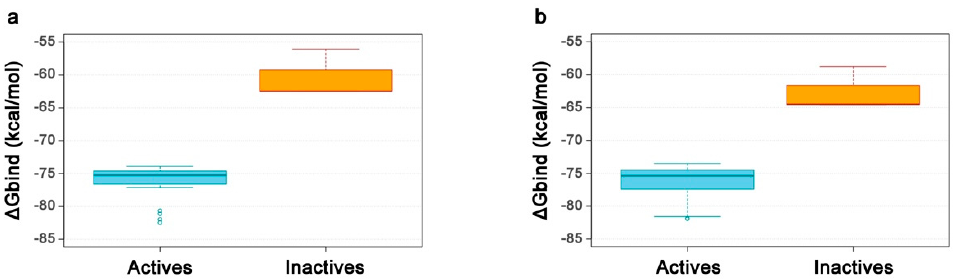
Figure 7. Box-plots showing ∆ G bind distribution obtained for active and inactive compounds using Prime MM-GBSA. ( a ) Default setting, only ligands are relaxed ( b ) also protein residues around 3 Å from the ligands are treated as